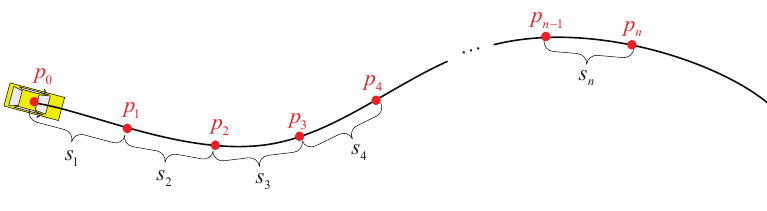
Figure 15. An example path.